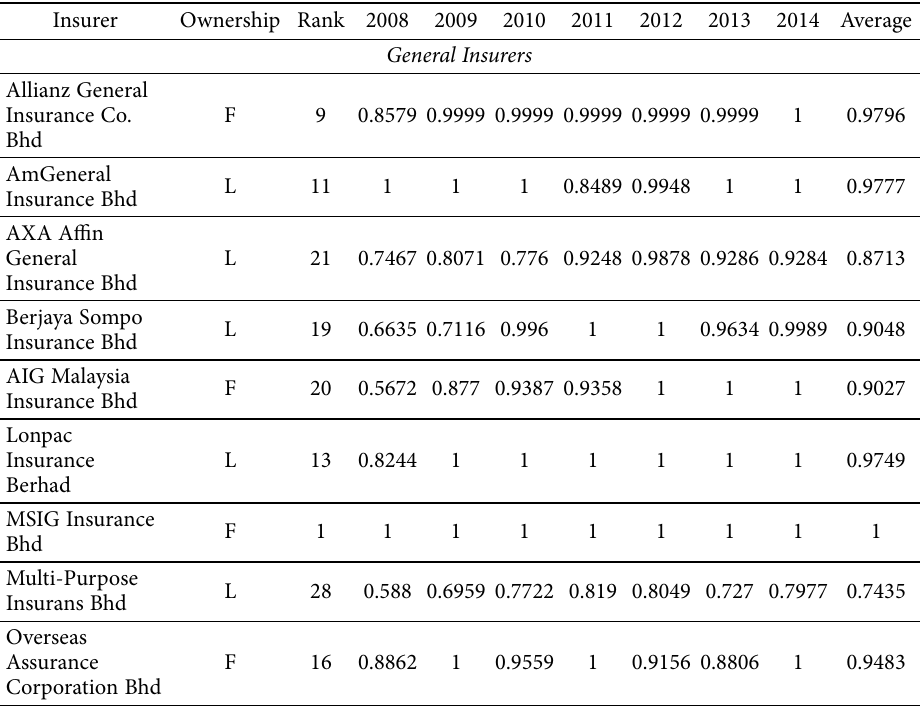
Table 5. Premium accumulation efficiency scores for Malaysian